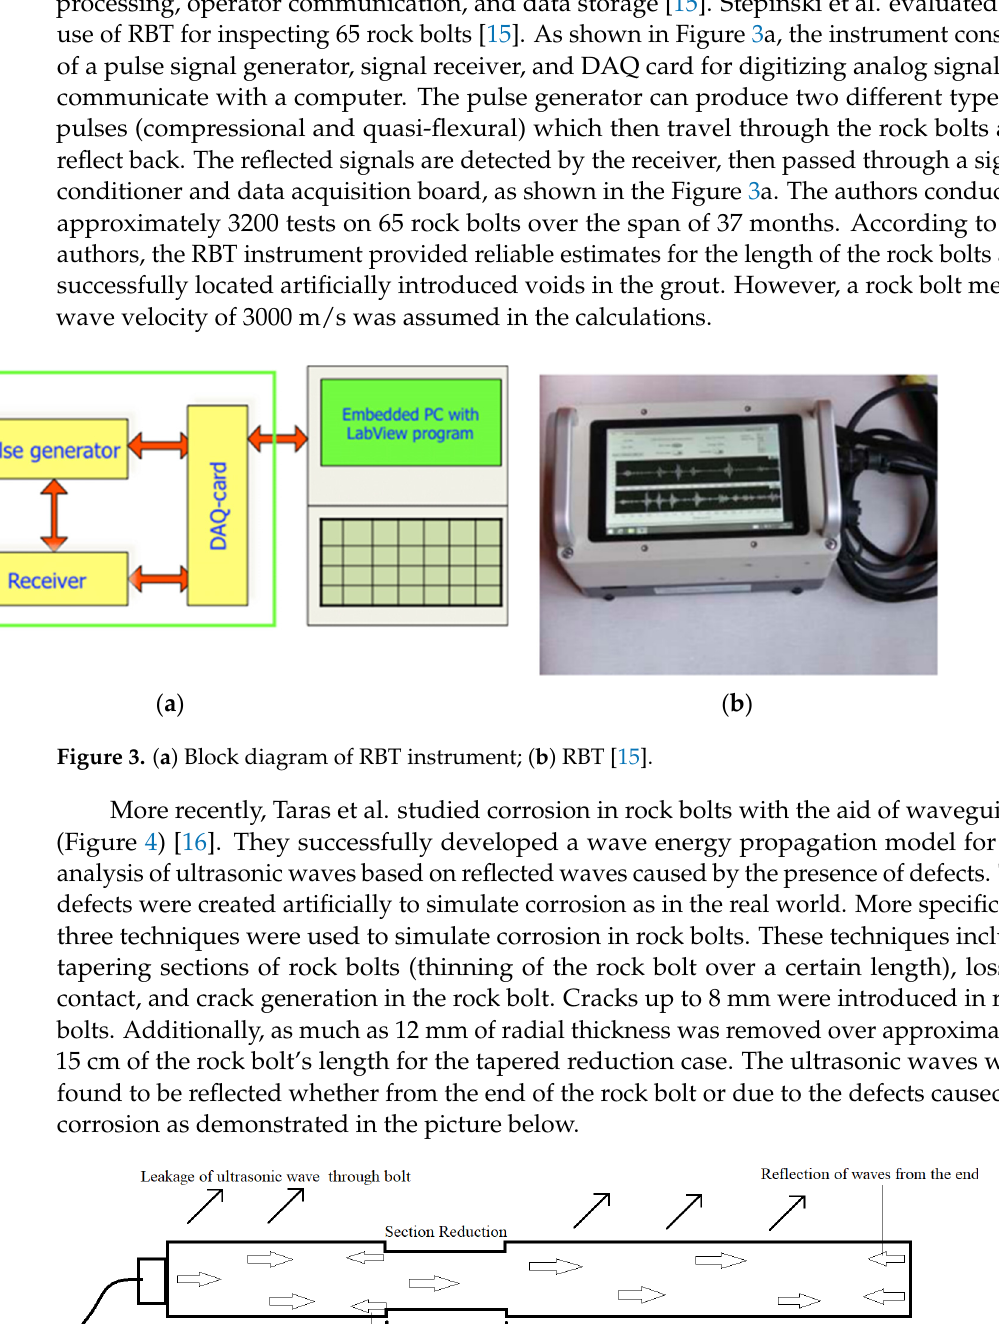
Figure 2. ( a ) an example of energy velocity dispersion curves for the rock bolt model; ( b ) Schematic diagram of the rock bolt installation using guided waves inspection [14].